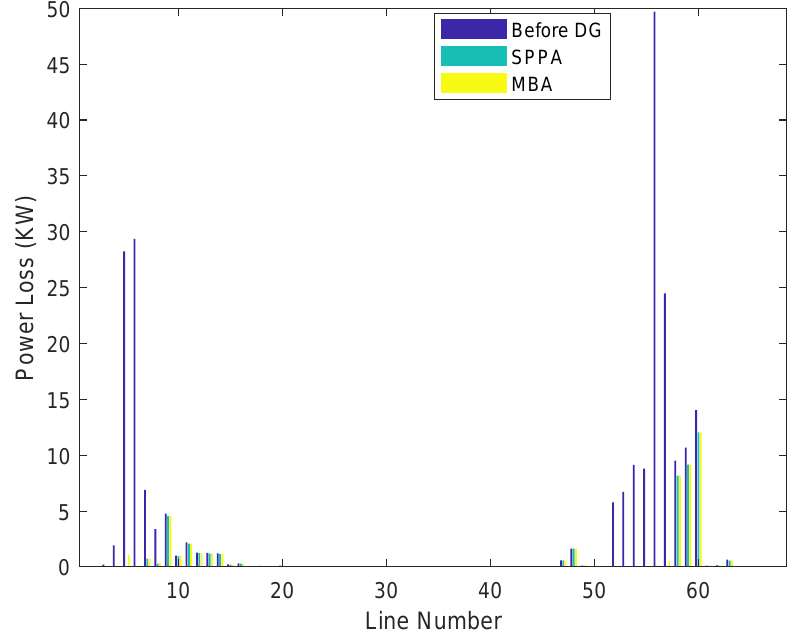
Figure 7. Active power loss results of NW-2.